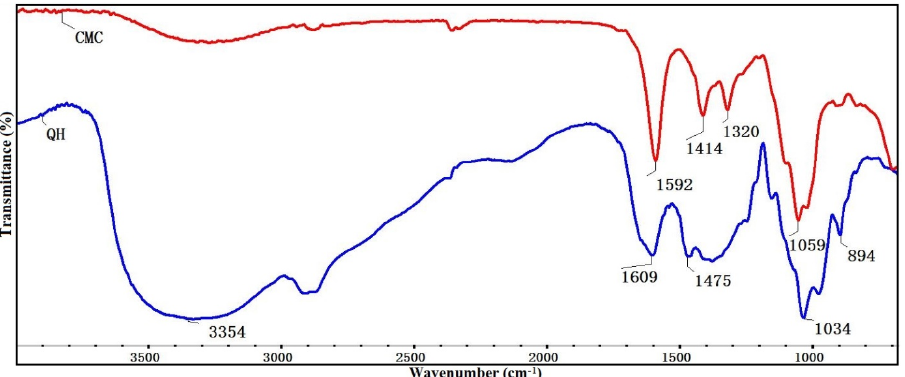
Figure 1. The FT ‐ IR spectra of CMC and QH.